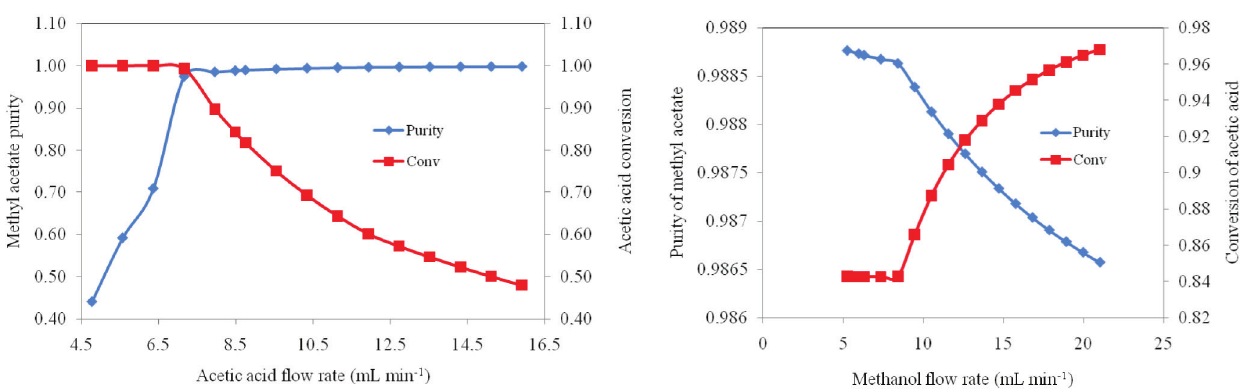
Fig. 11 – Effect of acetic acid feed flow rate on the methyl acetate purity and acetic acid conversion